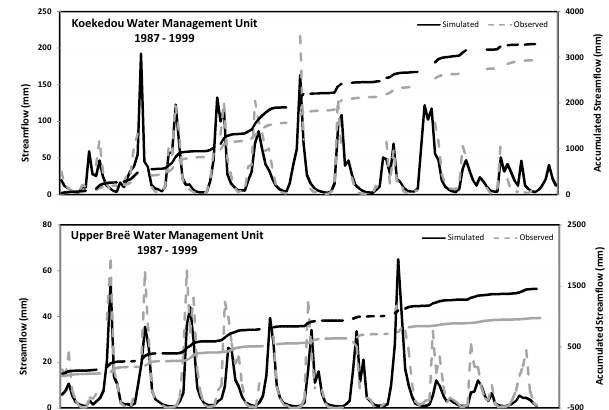
Fig. 11. Comparison of monthly totals of daily simulated and ob- served streamflows for (from top to bottom) the Koekedou WMU and the Upper Bre¨e WMU of the Upper Breede Catchment.